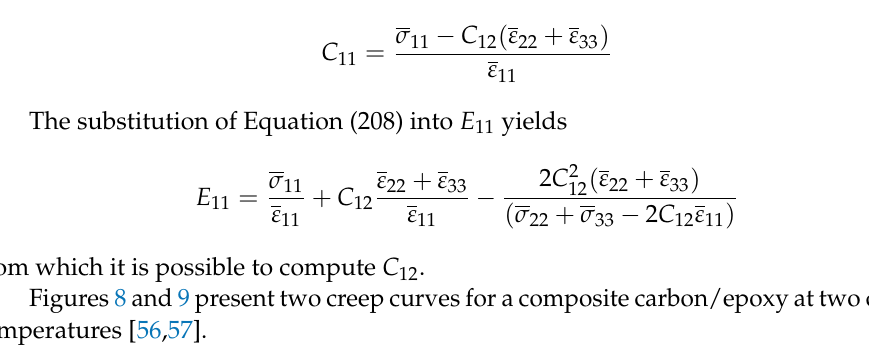
Figure 9. Creep response of a carbon/epoxy {90} 4s at T = 100 °C.